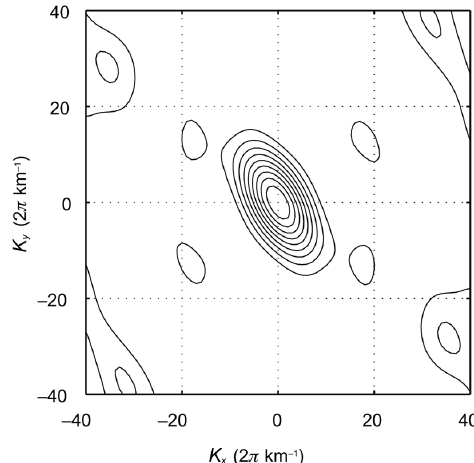
Fig. 3. Broad-band beam pattern spectrum (see eq. (3.1) in text) representing the response of the array to a monochromatic, vertically-inciding plane wave. K x and K y are the two components of the wavenumber vector with respect to a Cartesian system in which the x - and y -axes are oriented W-E and S-N,